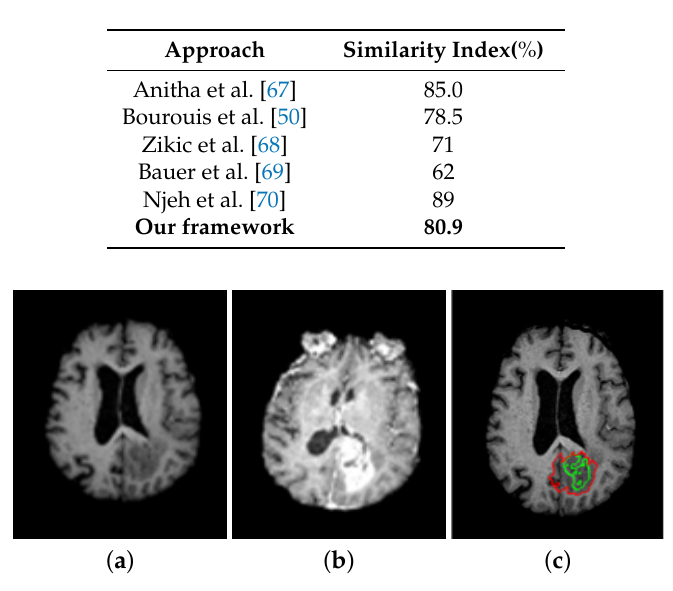
Figure 3. Result of the tumor detection: ( a ) T1w weighted magnetic resonance imaging (MRI) (T1w: is the T1 before contrast injection) ( b ) T1 weighted MRI ( c ) Final segmented tumor region (red), and initial detection classification with SVM (green).